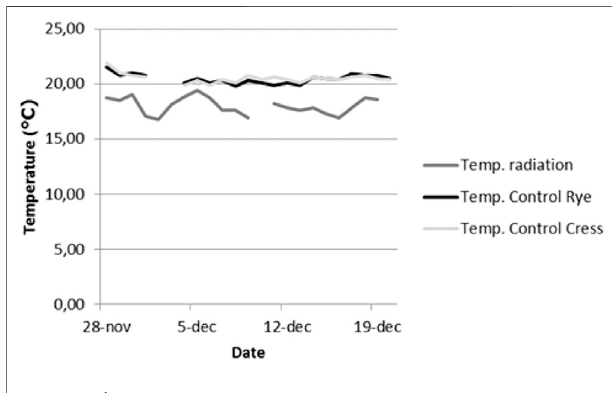
FIGURE 2 | Temperature changes over the course of the experiment for control and radiation fume hoods. Gaps in lines indicate missing data. Temperatures were obtained with a 2-in-1 humidity- and temperature measurement device (see also Supplementary Appendix 4